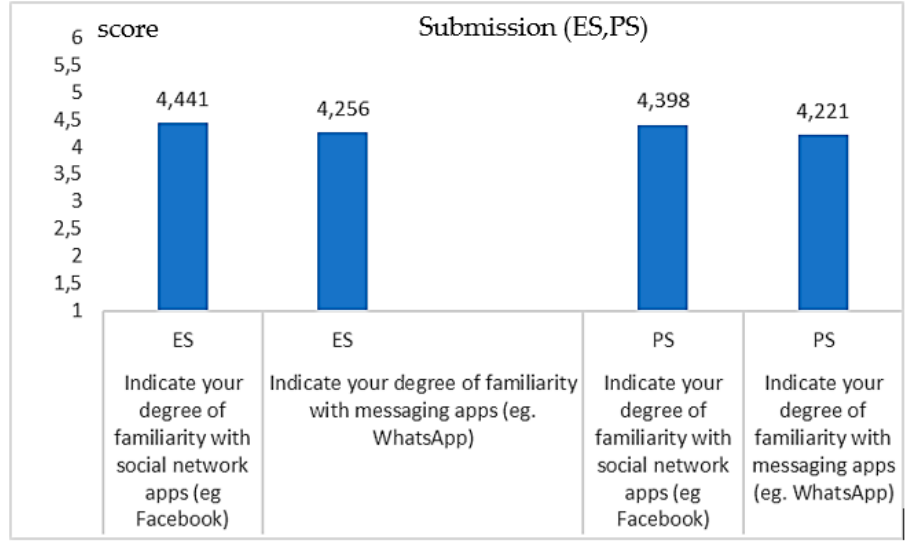
Figure 2. Coherence in the degree of familiarity with social networks, Q16 ( p = 0.217) and messag- ing Apps, Q17 ( p = 0.237) both for the ES and the PS. The graphic indicates a high coherence be- tween the two groups.